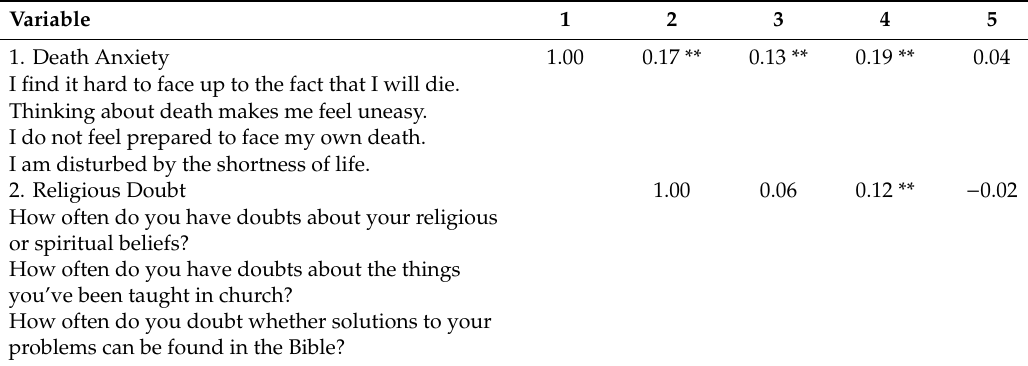
Table 2. Items and Pearson Correlation Coe ffi cients of Study